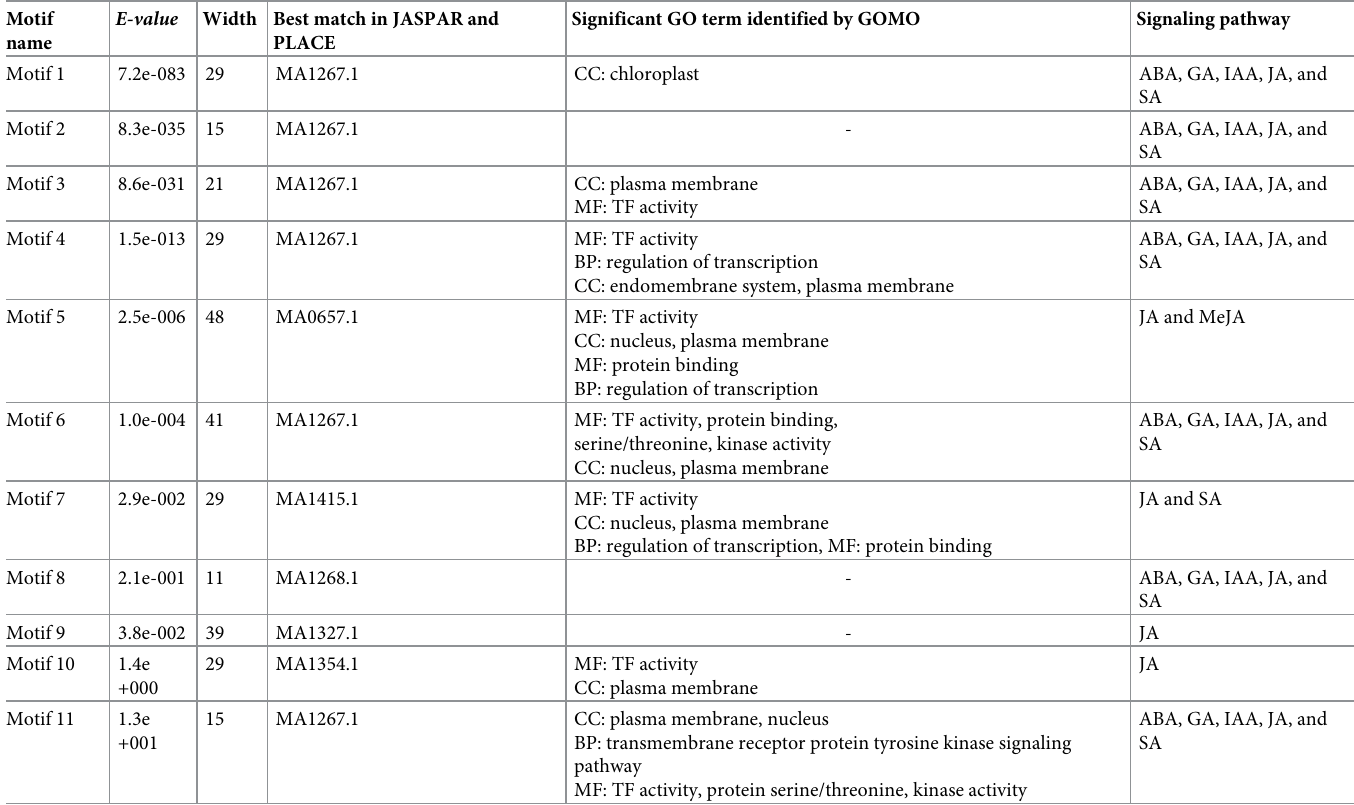
Table 5. The conserved cis-acting elements found in the promoter of biotic DEGs by the MEME analysis.